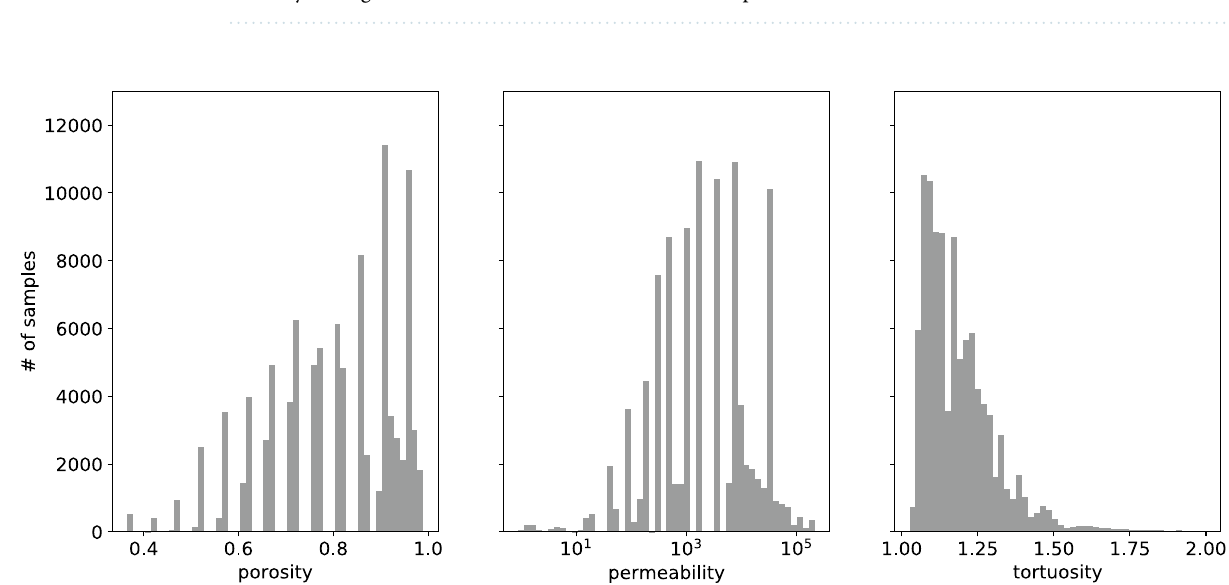
Figure 3. The distribution of the generated samples (training and validation data sets together) with respect to porosity, permeability, and